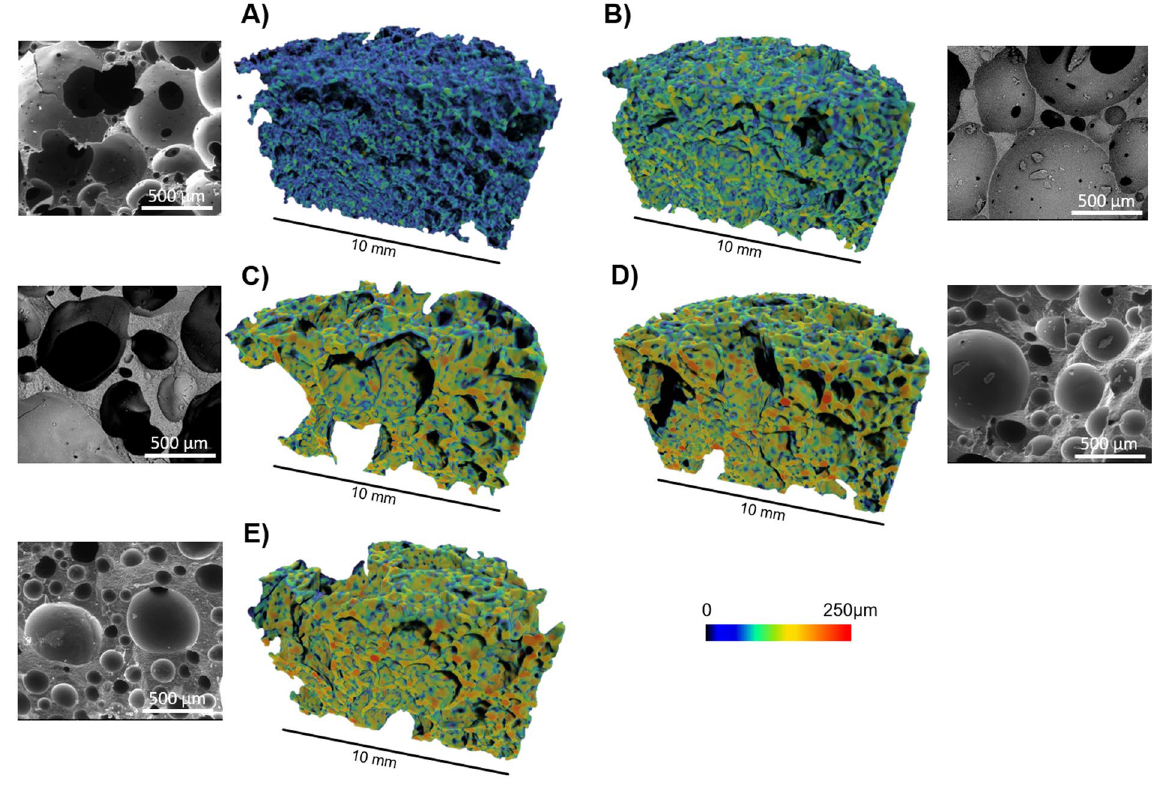
Figure 7. Morphological characterization of direct-foamed samples (with an equimolar concentration of surfactants) in order of ascending cell wall thickness (shown with the color bar): ( A ) sodium dodecyl sulfate (SDS); ( B ) cetyltrimethylammonium bromide (CTAB); ( C ) Triton X-405; ( D ) Triton X-100; ( E ) Triton